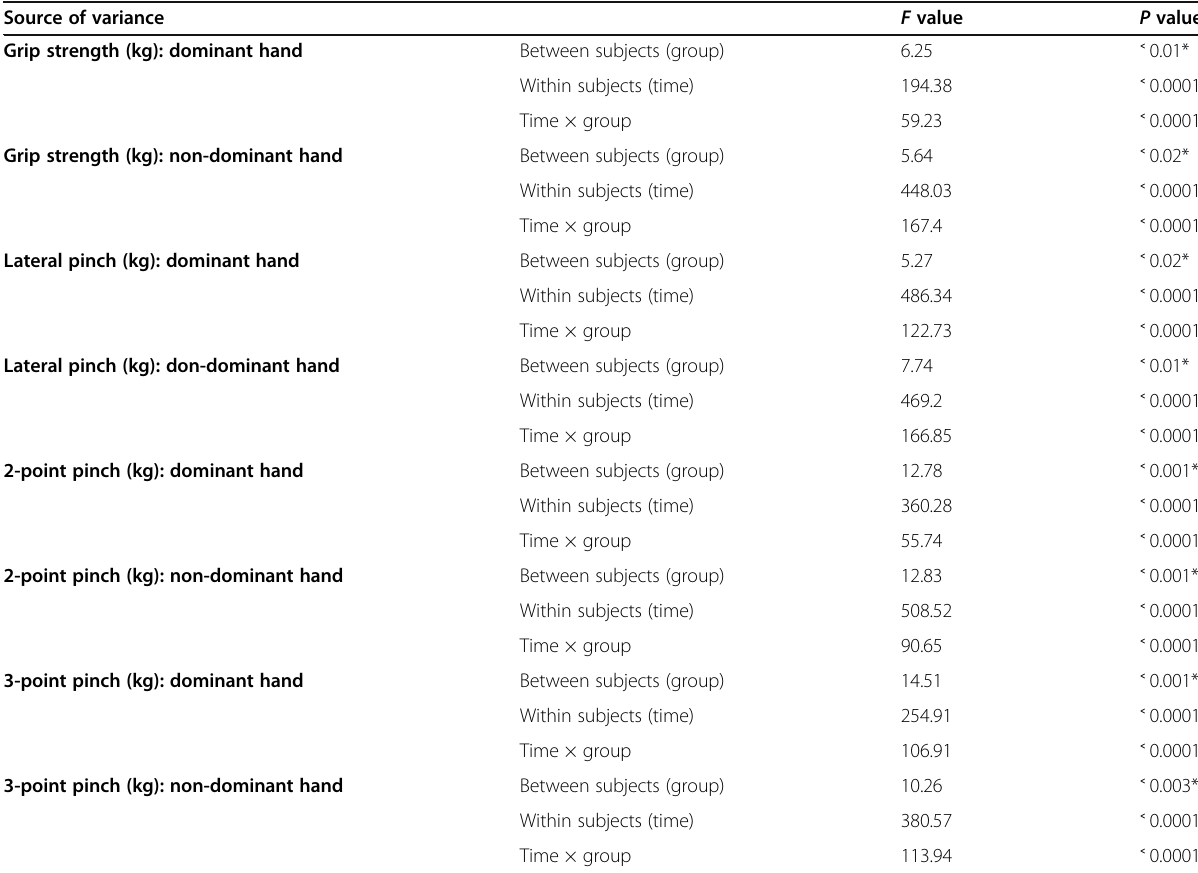
Table 2 Results of a 2 × 2 mixed-model ANOVA Source of variance